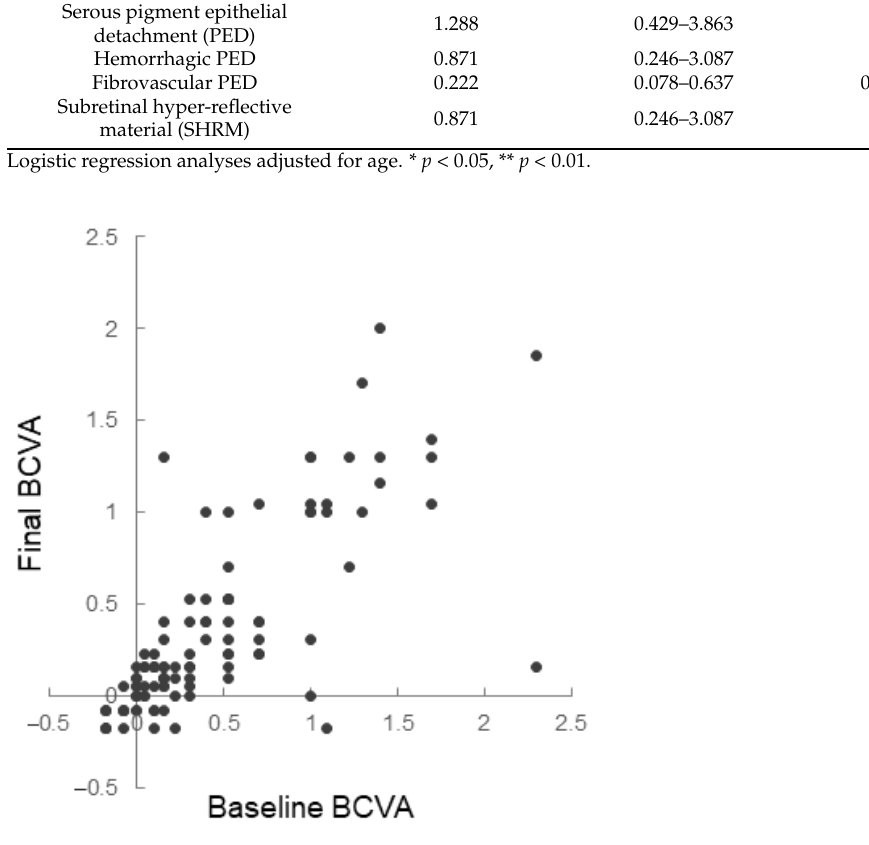
Figure 1. Scatter plots of baseline and final best-corrected visual acuity (BCVA) of the individual eyes. BCVA is expressed after conversion to the logarithm of the minimum angle of resolution.